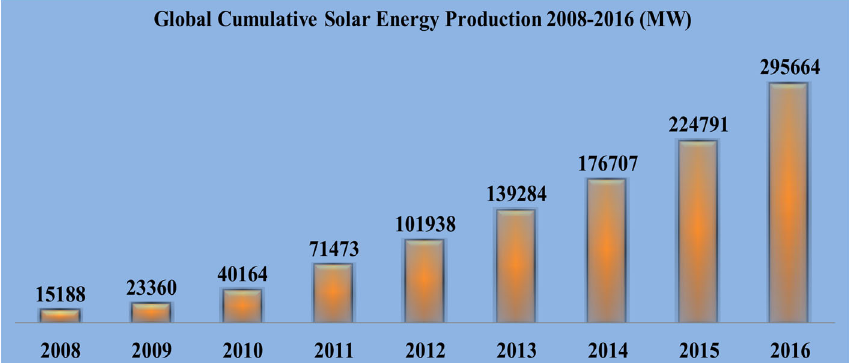
Fig. 4 Global Cumulative Solar Energy Generation in 2008-2016 [8,